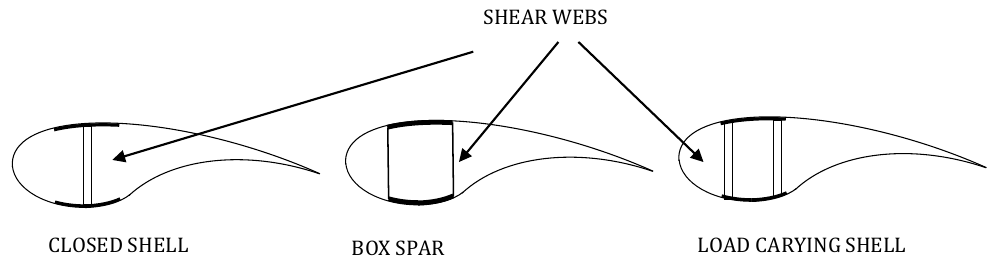
CLOSED SHELL Figure 2. Cross-section of the WTB with different shear web